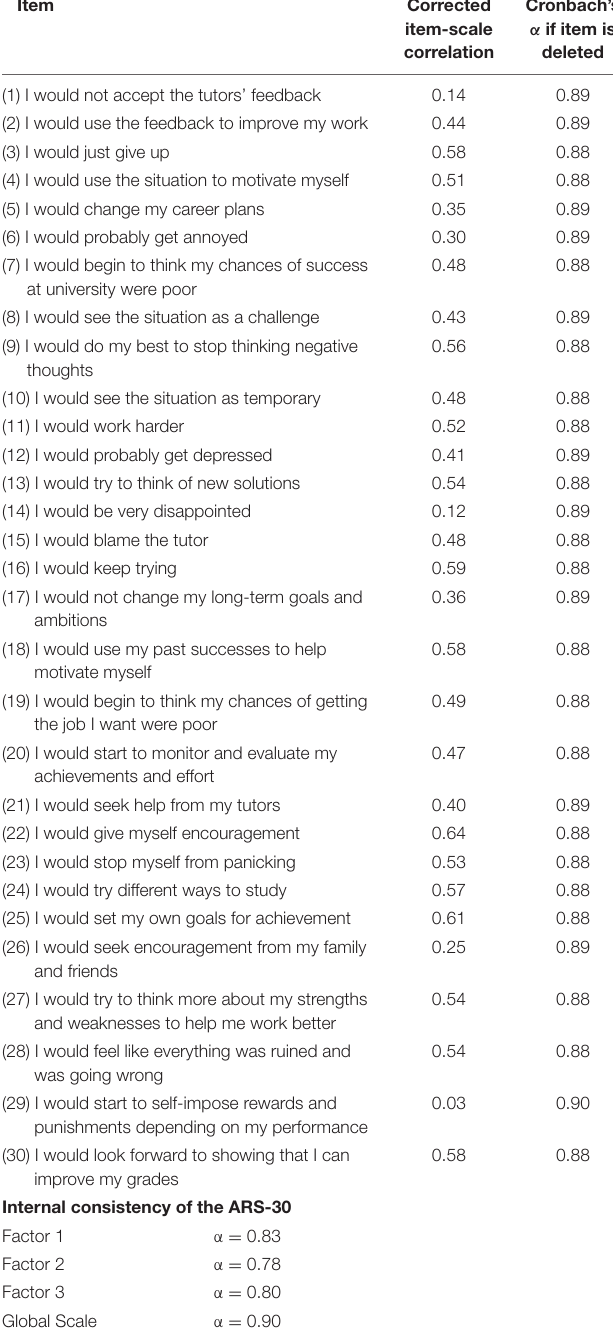
TABLE 6 | Item-scale analysis of the